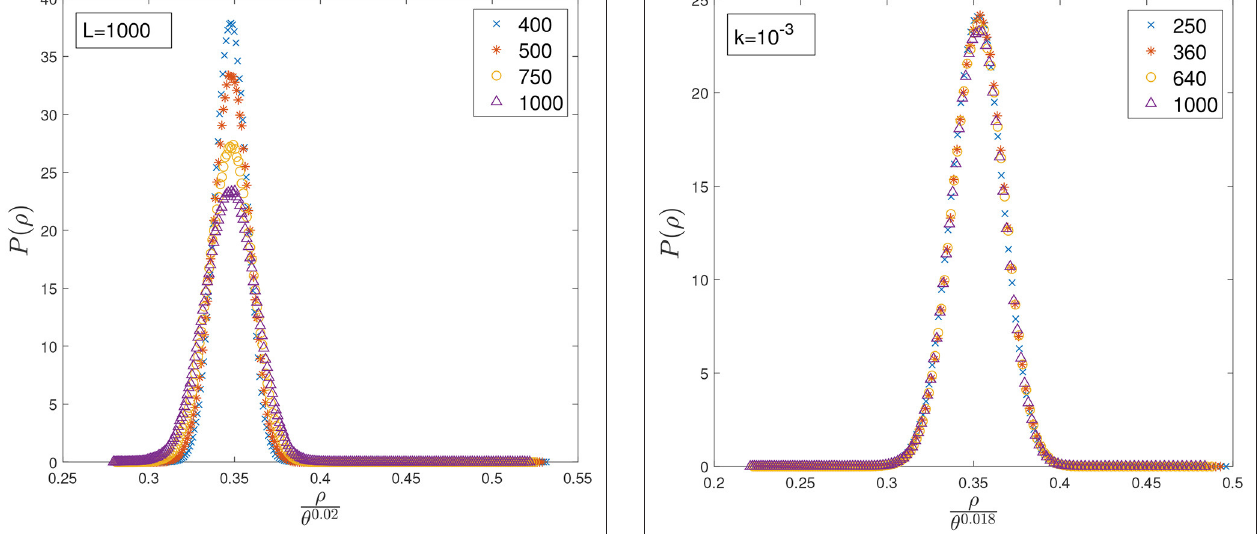
FIGURE 2 | Distribution of densities P ( ρ ) computed at different values of θ and k = 10 − 3 . Although rescaling the x-axis by θ 0.018 seems to make it possible to perform a data collapse for θ ∈ [250,1000], this does not hold for larger values of θ .